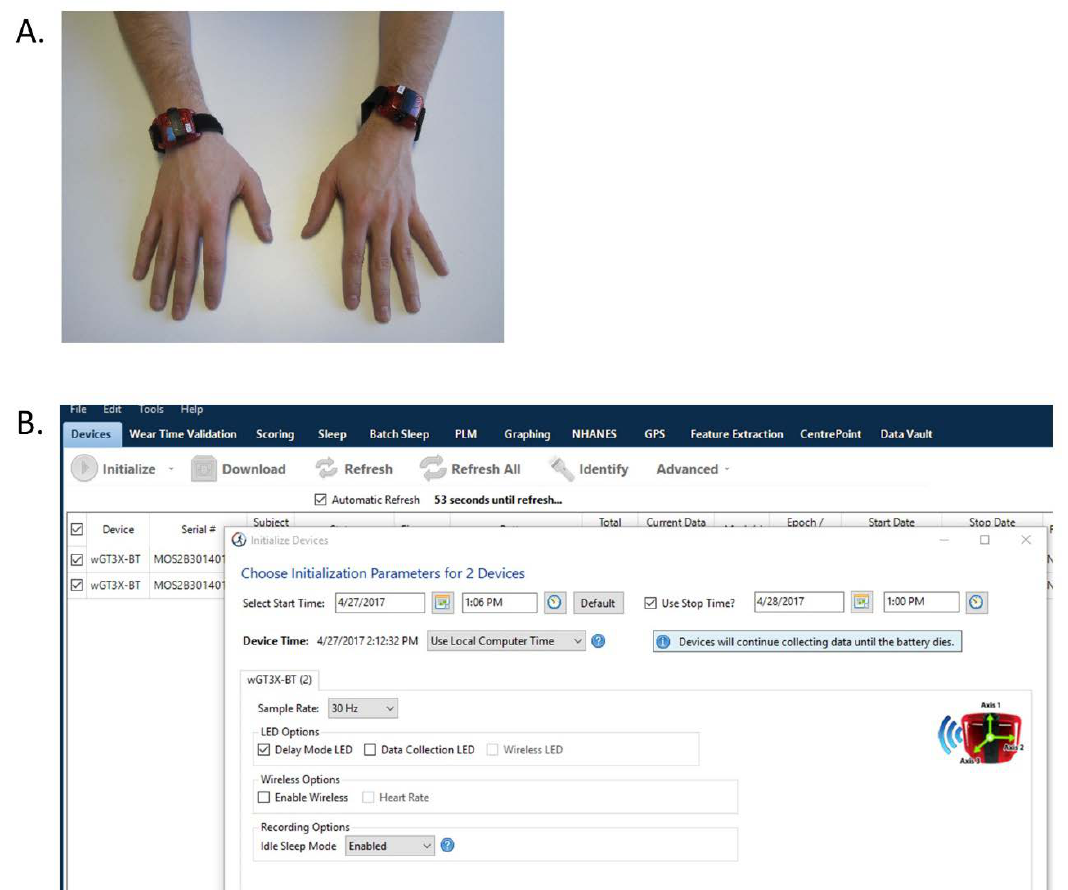
Figure 4. ( A ): Photo of a participant wearing the Actigraph wGT3X-BT devices on each wrist. ( B ): A screen shot of the ActiLife software interface used to interact with the wearable device. The software provides options to change various recording parameters (start and stop times, sampling rate, etc.) prior to recording / collecting